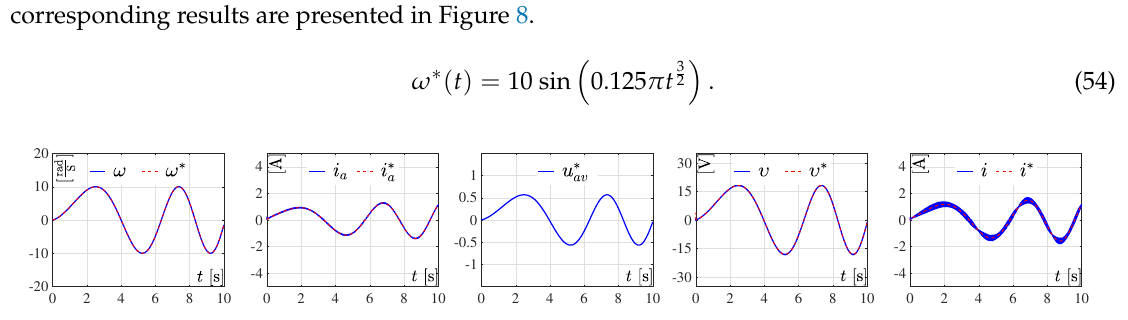
Figure 8. Circuit simulation results for a sinusoidal trajectory with time-varying frequency. The results related to the mathematical model correspond to the signals denoted by ω , i a , υ , i , and the results associated with the reference variables are labeled as ω ∗ , i ∗ a , u ∗ av , υ ∗ , i ∗ .